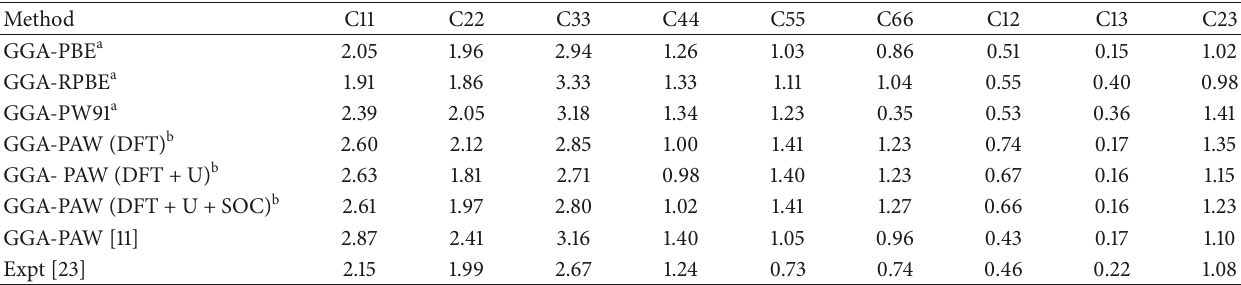
Table 2: Experimental and calculated elastic constants of uranium (M bar).